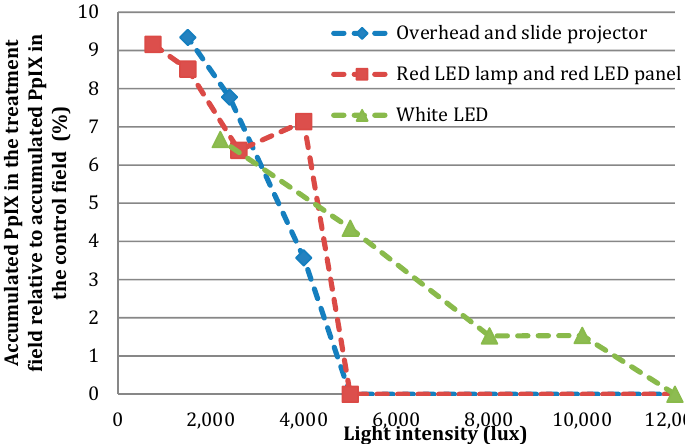
Figure 4. Percentage of unbleached PpIX by different light intensities.